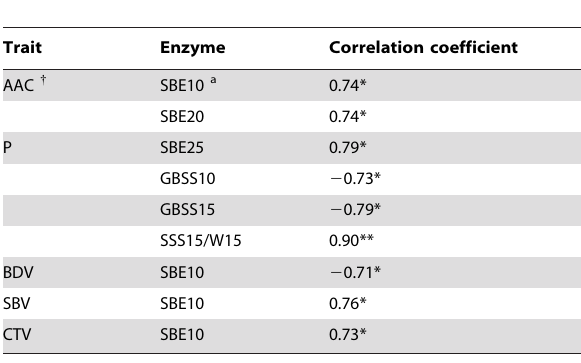
Table 4. Correlation analysis between eating quality traits and enzyme activities during rice grain